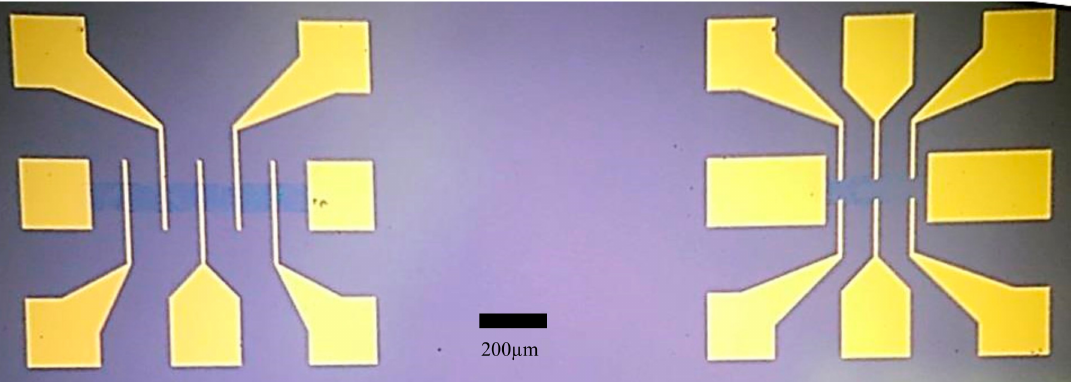
Figure 1. Graphene field effect transistor (FET) devices with asymmetric ( left ) and symmetric ( right ) voltage sense electrodes. Graphene channels, in the central regions of the FET devices, have a dark blue contrast compared to the Si/SiO 2